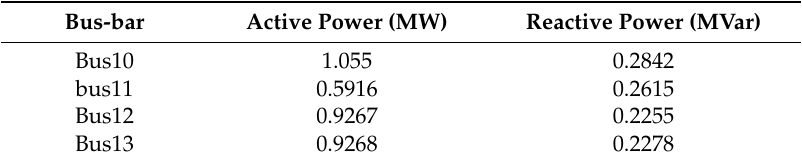
Table 1. Load demand in